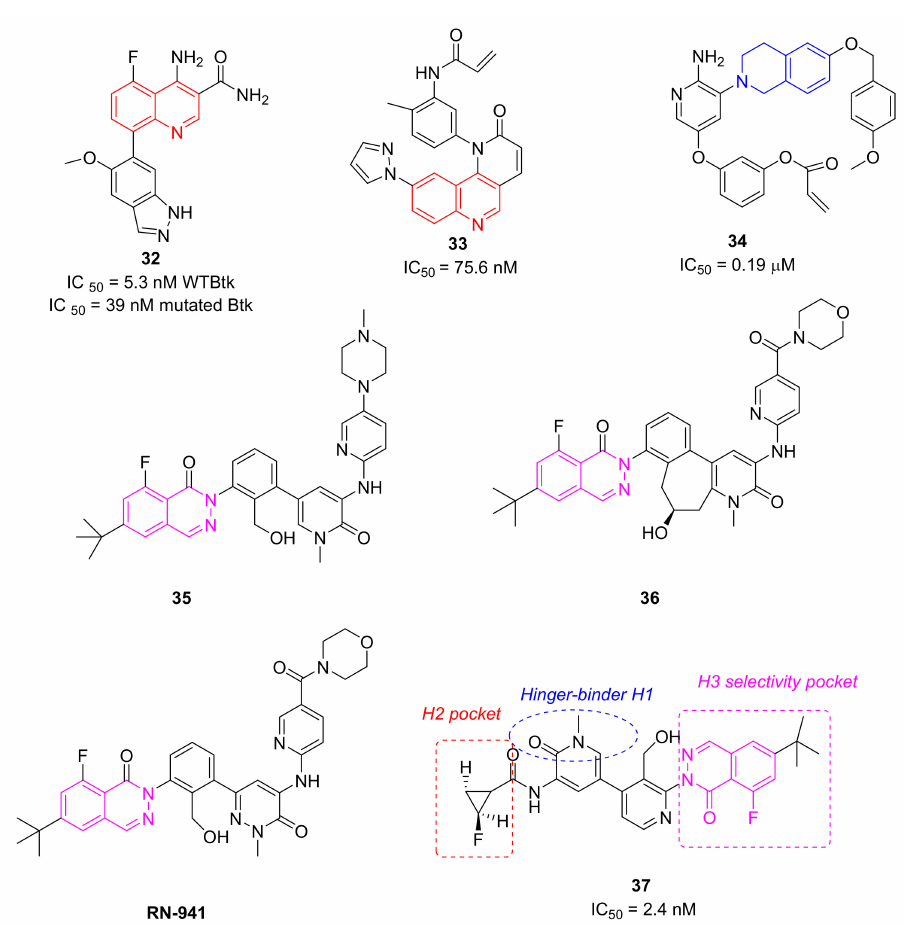
Figure 10. Quinoline, isoquinoline and phthalazine